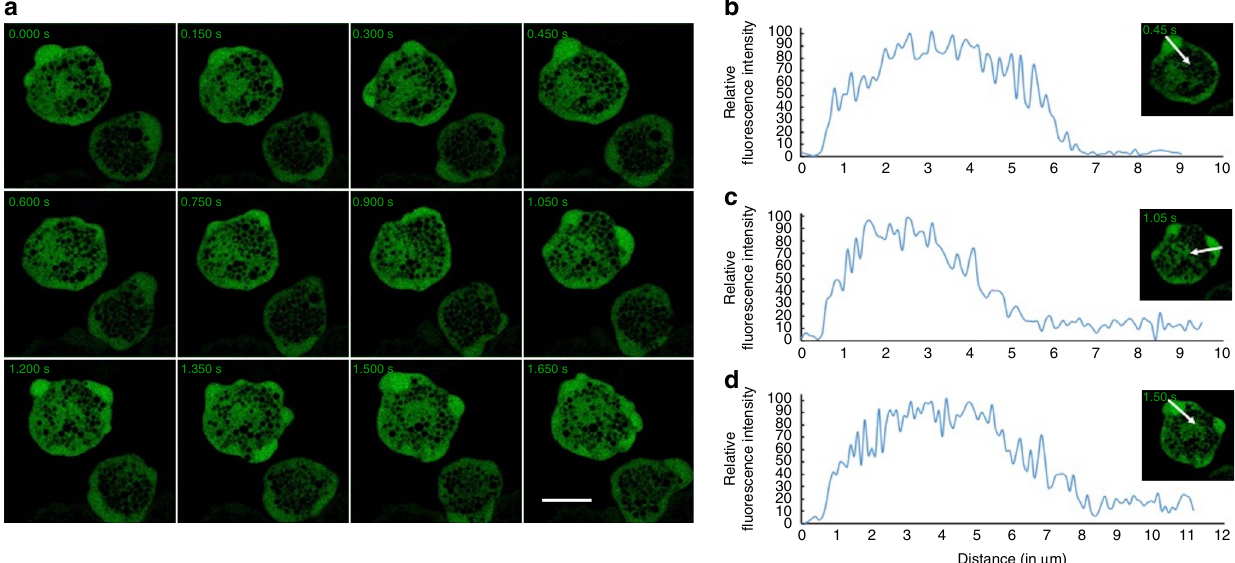
Fig. 4 Live imaging montage showing localization of GFP-EhAGCK1 in normal motile trophozoites. a Montage showing a time series of motile trophozoites expressing GFP-EhAGCK1. A number of pseudopods in different directions can be visualized. b – d The pseudopods in three different time frames have been analysed for GFP-EhAGCK1 intensity along the marked arrow line . The graph shows intensity of GFP-EhAGCK1 in pseudopods vs. cytoplasm and plasma membrane along the line . ( Scale bar , 10 μ